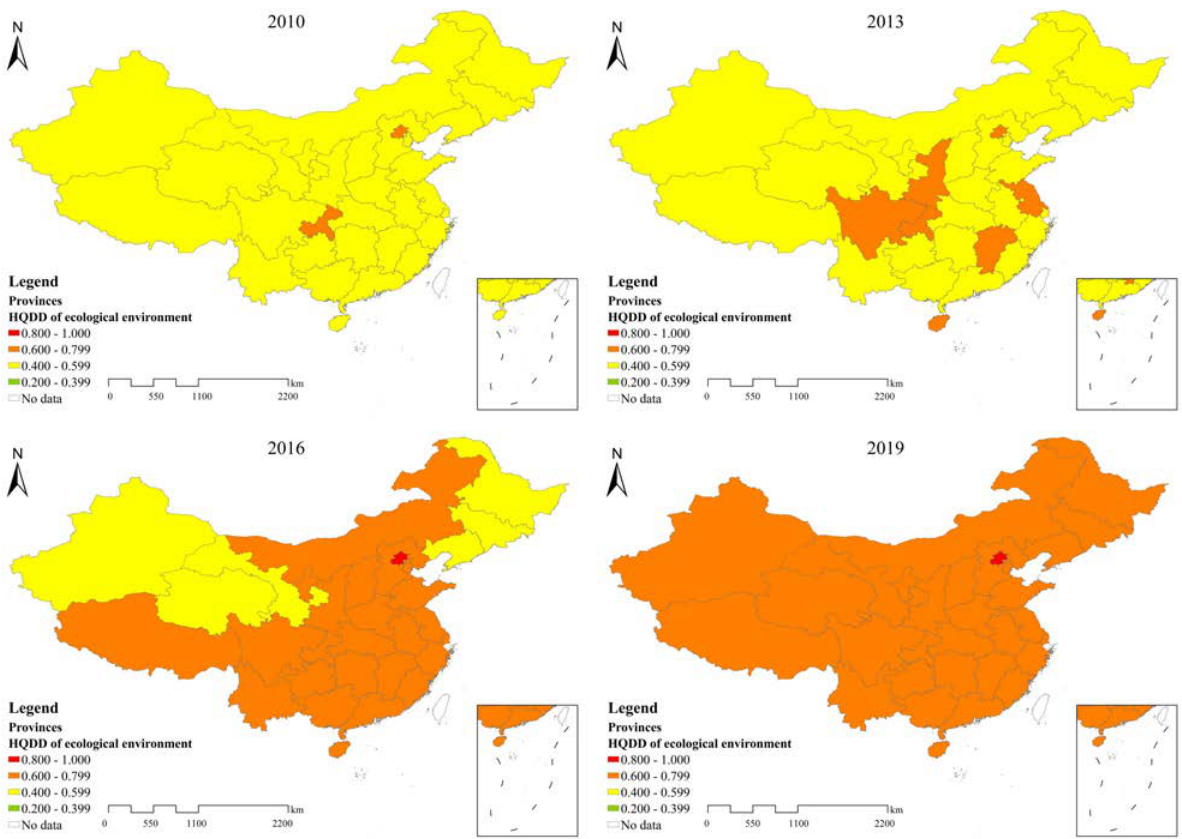
Figure 6. Spatial distribution of HQDD of the ecological environment system in 31 PLARs in 2010, 2013, 2016, and 2019.